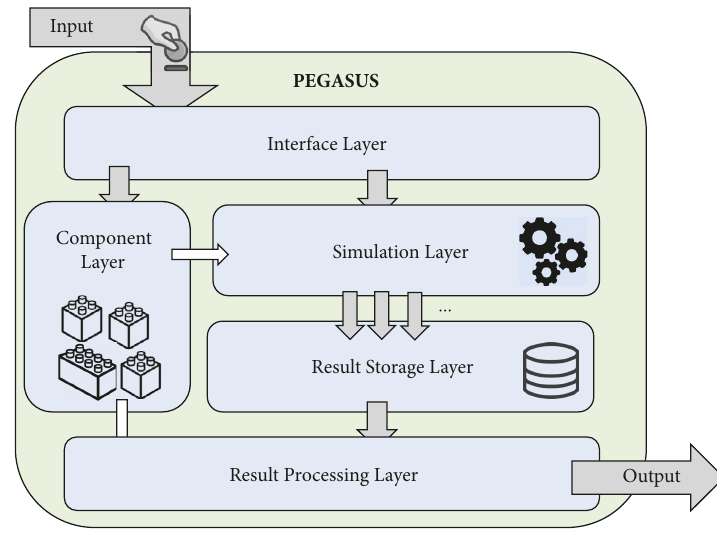
Figure 4: Pegasus architecture.